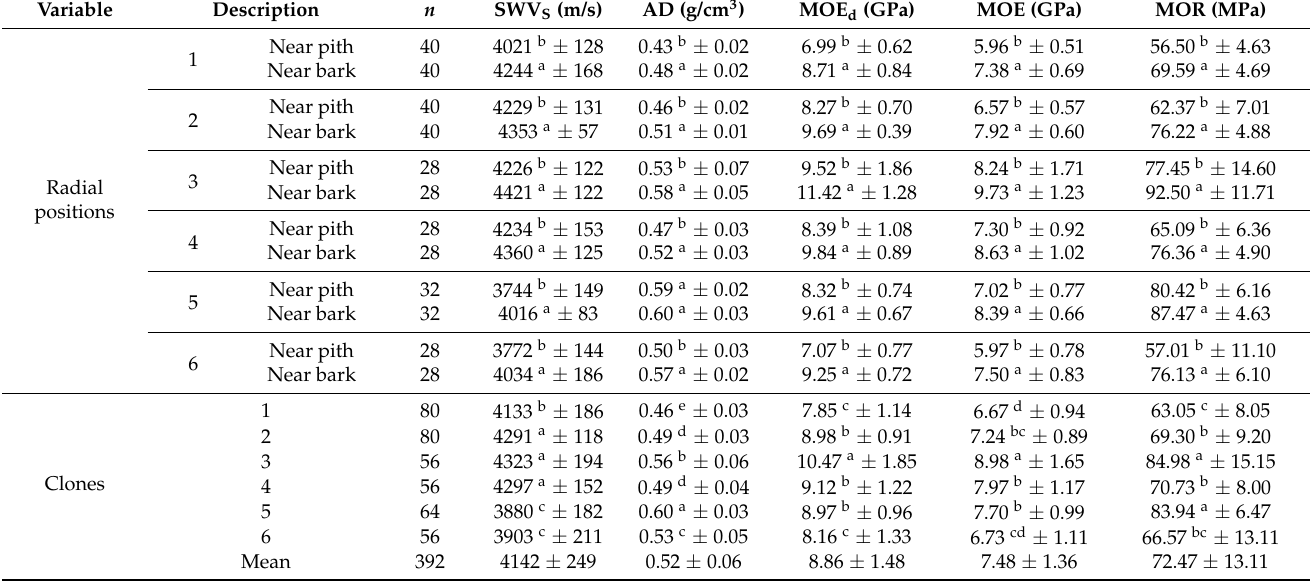
Table 3. Stress wave velocity and wood properties of six different Eucalyptus clones planted in Vietnam.